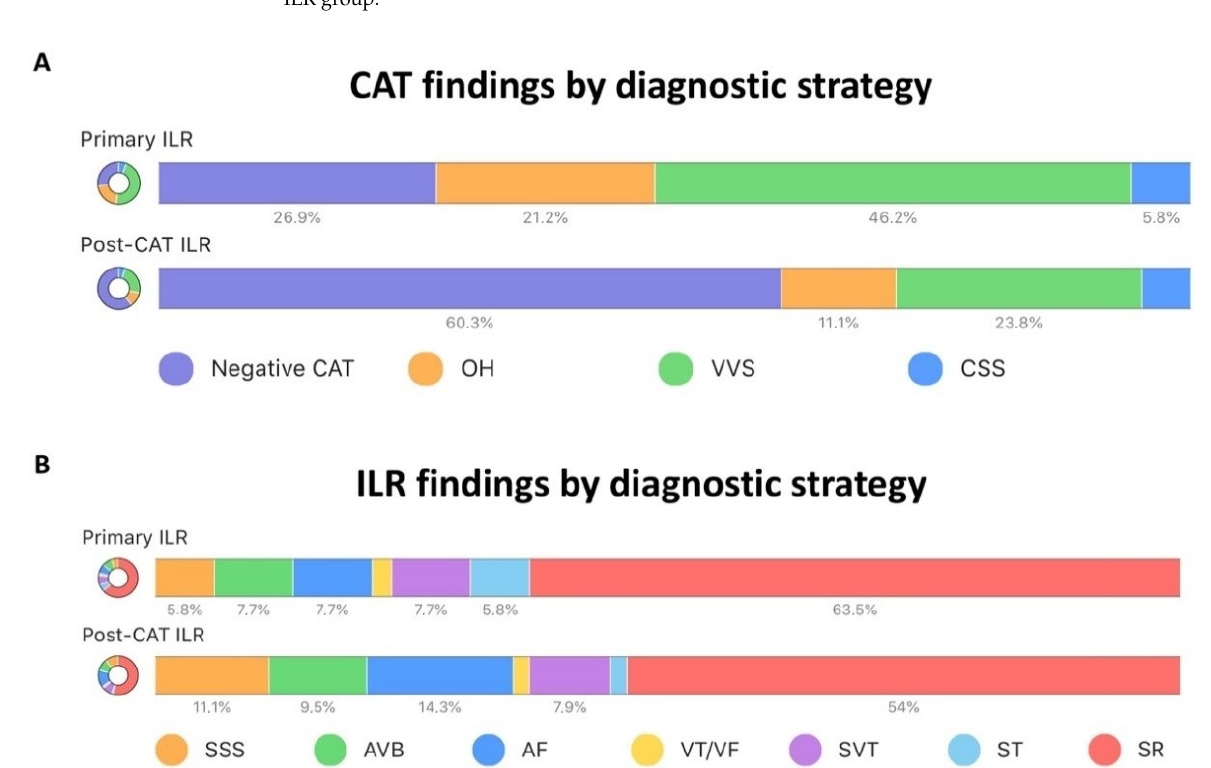
Figure 1. Unexplained syncope patients are compared in terms of diagnostic findings in the two groups: primary ILR implantation and post-CAT ILR implantation. Panel ( A ): CAT findings by diagnostic strategy. Panel ( B ): ILR findings by diagnostic strategy. CAT, cardiovascular autonomic testing; ILR, implanted loop recorder. VVS, vasovagal syncope; OH, orthostatic hypotension; CSS, carotid sinus syndrome; SSS, sick sinus syndrome; AVB, atrioventricular block; AF, atrial fibrillation; VT/VF, ventricular tachycardia/ventricular fibrillation; SVT, supraventricular tachycardia; ST, sinus tachycardia; SR, sinus rhythm.